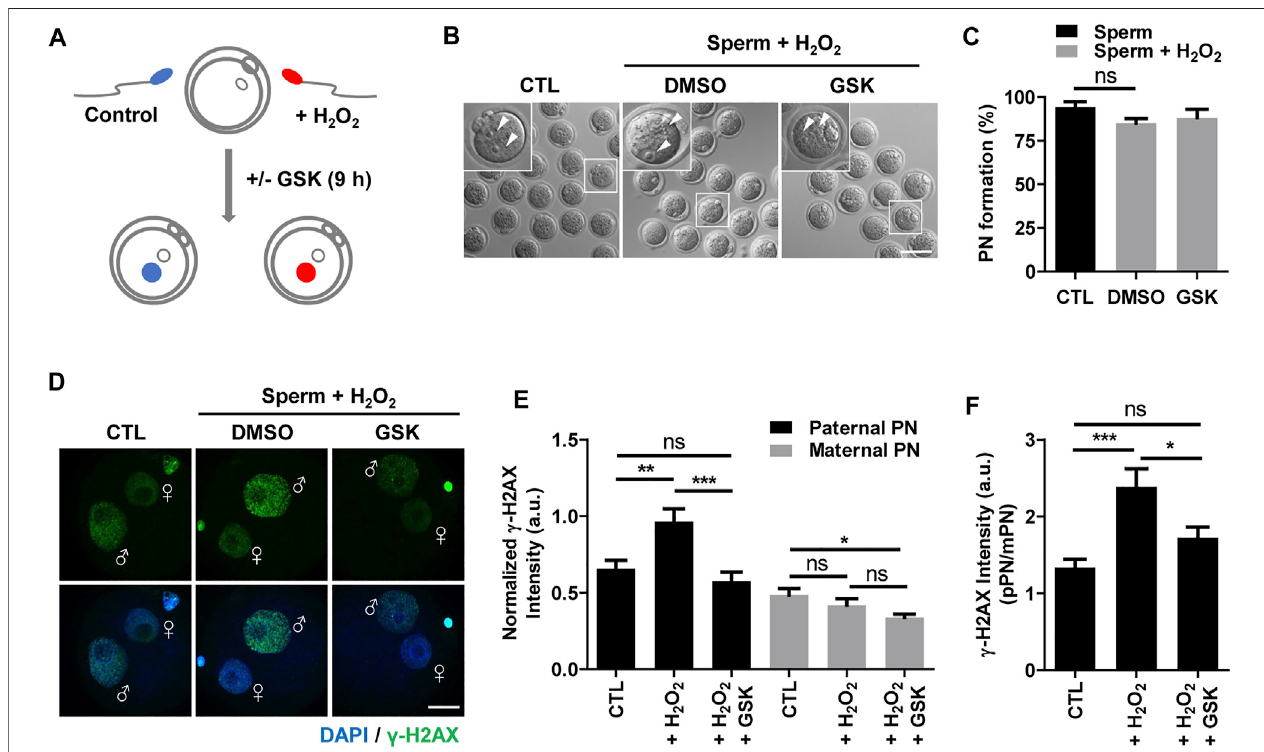
FIGURE2| WIP1inhibitionenhancesDNAdamagerepairinzygotes. (A) Schematicdiagramoftheexperiment.Afterinseminationwithspermtreatedwith100 μ M hydrogen peroxide (H 2 O 2 ) for 1 h, oocytes were cultured with or without GSK for 9 h. Fresh sperm were used as a control. (B,C) The rate of pronuclear (PN) formation was shown with representative images at 9 h after ICSI. Scale bar, 100 μ m. Arrowheads indicate pronucleus. (D,E) The γ -H2AX intensity in paternal and maternal pronucleiwasnormalizedtothemeanDAPIintensityoftwoindependentexperimentsandshownwithrepresentativeimages. _ and \ indicatethepaternalPNand maternal PN, respectively. Scale bar, 20 μ m. (F) The γ -H2AX intensity ratio of the paternal/maternal pronuclei was quanti fi ed. Data are expressed as mean +SEM. * p < 0.05, ** p < 0.001, and *** p < 0.0001, ns; not signi fi